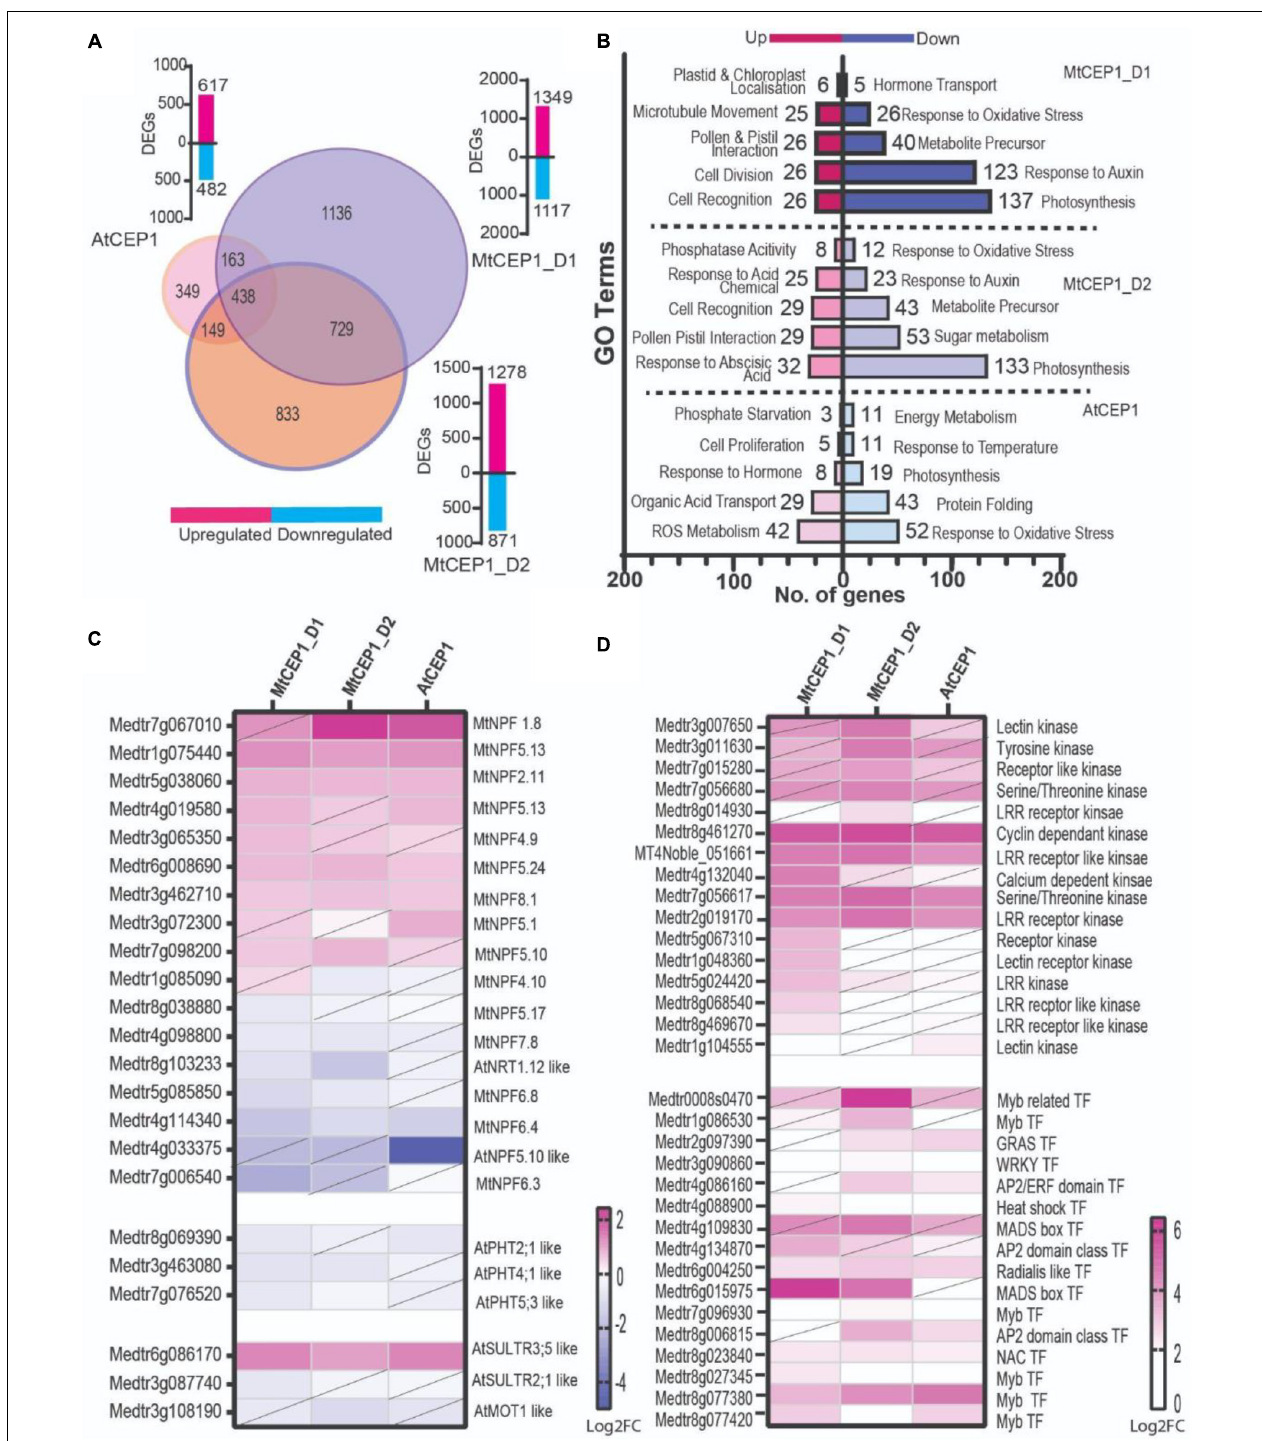
FIGURE 4 | Differential gene expression analysis (A) Venn diagram showing number of differentially expressed genes following application of AtCEP1p and MtCEP1 peptide domain 1 and 2 in M. truncatula (FC > 1.5, p < 0.05). Shared genes are indicated in the overlapping region between peptide treatments. Corresponding histogram shows the total number of DEGs. (B) Histogram showing the top twenty significantly enriched GO terms in up and down-regulated genes ( q < 0.05). (C) Heatmap of putative nitrate and sulfate transporter genes affected by MtCEP1D1, MtCEP1D2, and AtCEP1 peptide treatment in M. truncatula (FC > 1.5, p < 0.05, diagonal line indicates statistically insignificant value). (D) Comparative analysis of CEP1-responsive kinases and transcription factor genes in M. truncatula (log2FC > 1.5, p < 0.05, diagonal line indicates statistically insignificant value). Average values of three biological replicates are represented. TF stands for transcription